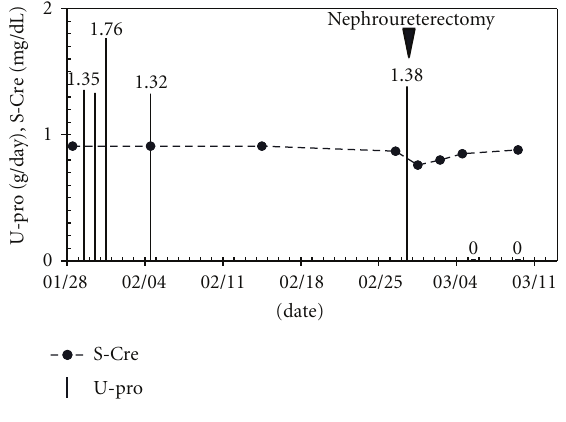
Figure 4: Clinical course of the